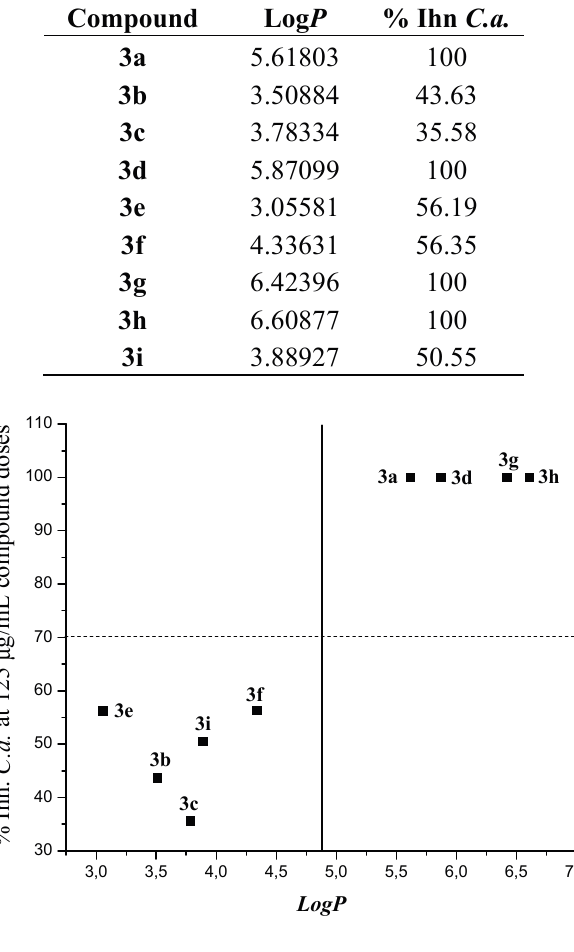
Figure 2. Log P vs. inhibition percentage of C. albicans growth, by 3a – i at 125 µg·mL − 1